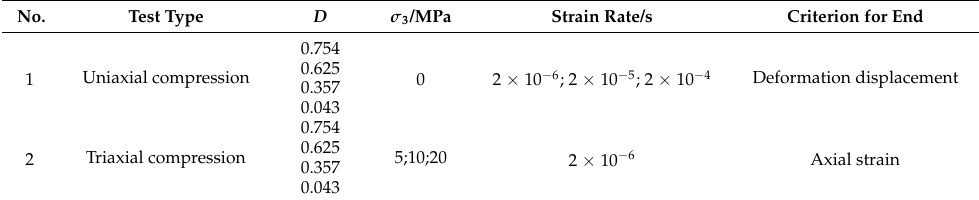
Table 5. Experimental scheme of static compression test.